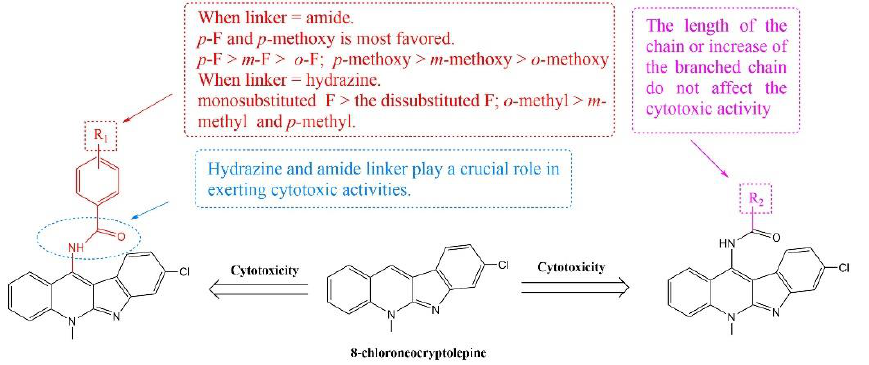
Figure 1. Structure-activity relationship analysis of neocryptolepine derivatives. Different colours indicated different substituted functional groups, and different arrows indicated different cytotoxic activities after functional group substitution.